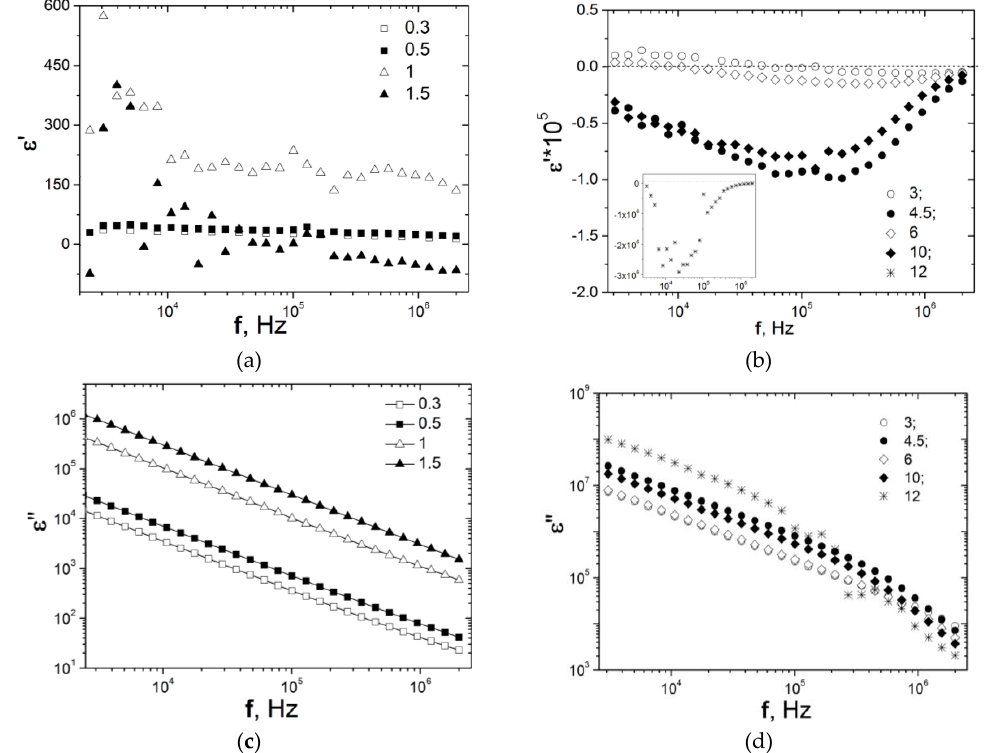
Figure 3. Real (a,b) and imaginary (c,d) parts of dielectric permittivity of PE-based composites filled Figure 3. Real ( a,b ) and imaginary ( c,d ) parts of dielectric permittivity of PE-based composites filled with carbon nanotubes versus frequency. with carbon nanotubes versus